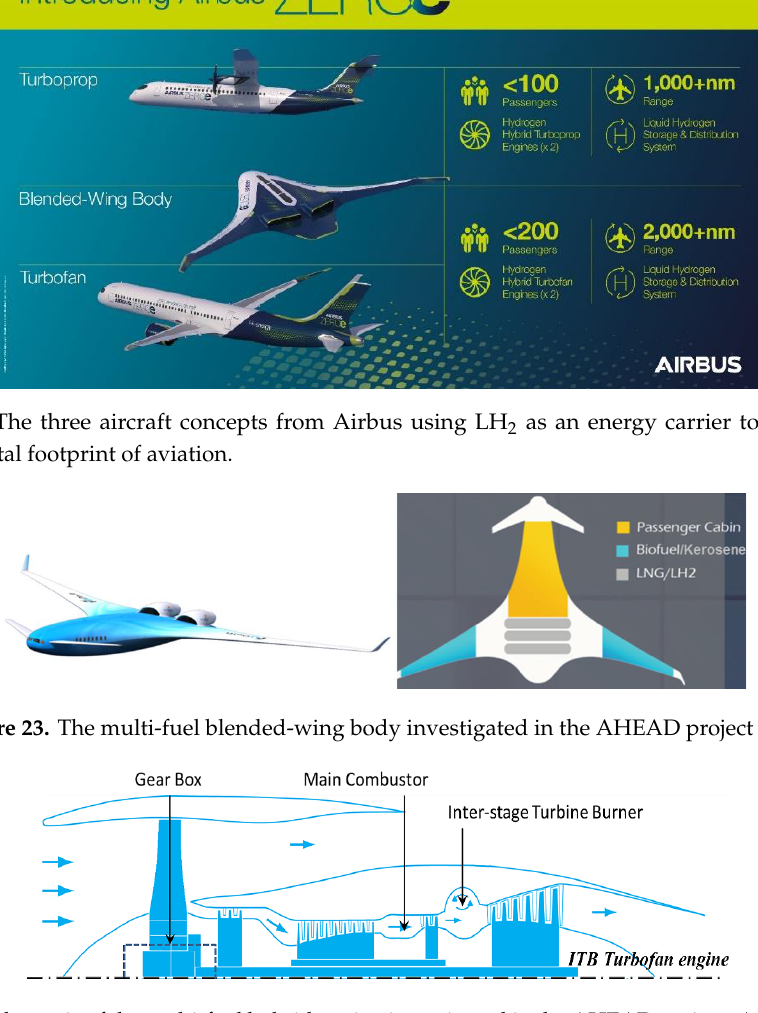
Figure 21. Change of energy consumption for H 2 -fueled aircrafts as compared to equivalent kerosene- fueled aircrafts [36].